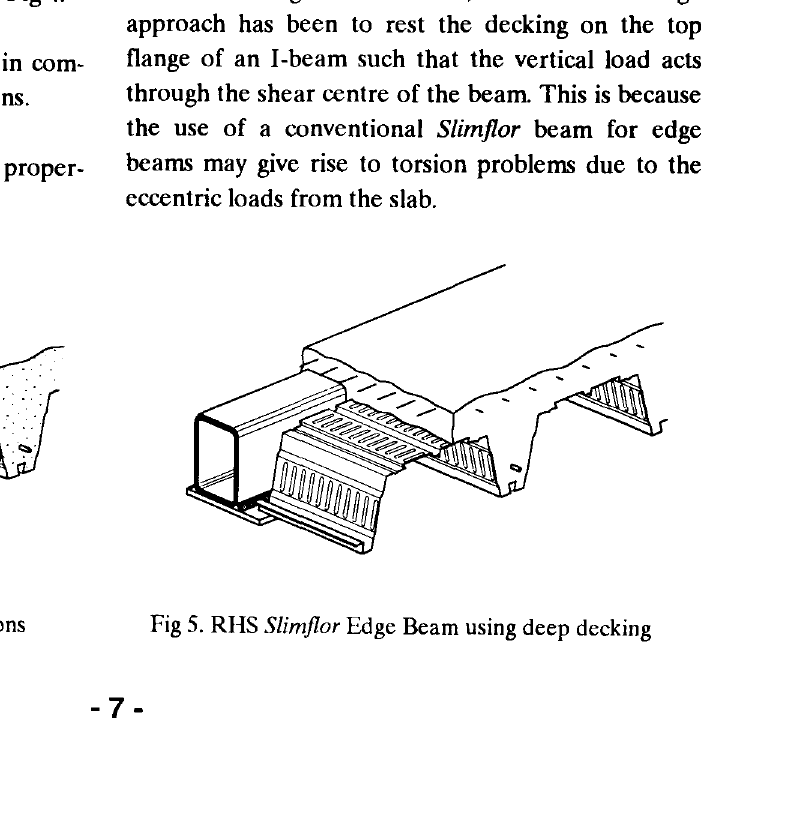
Fig 4.'Slimdek' construction using ASB sections Fig 5. RHS Slimjlor Edge Beam using deep decking